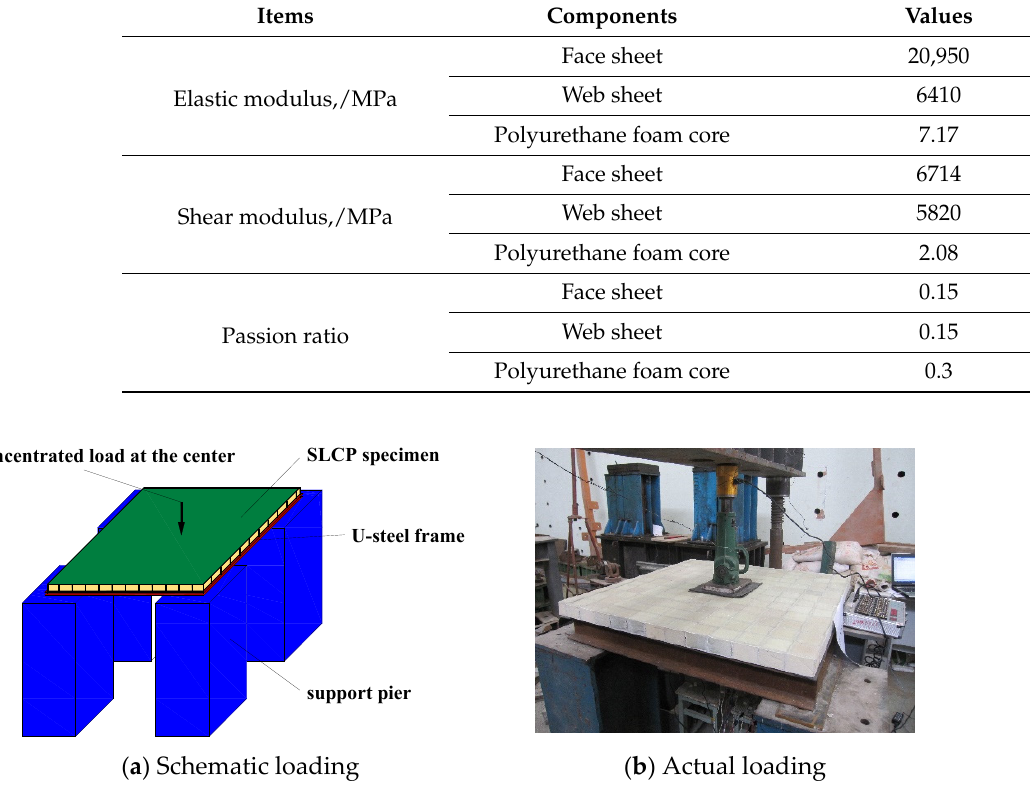
Figure 4. Loading schematic for two-way simply supported SLCPs.